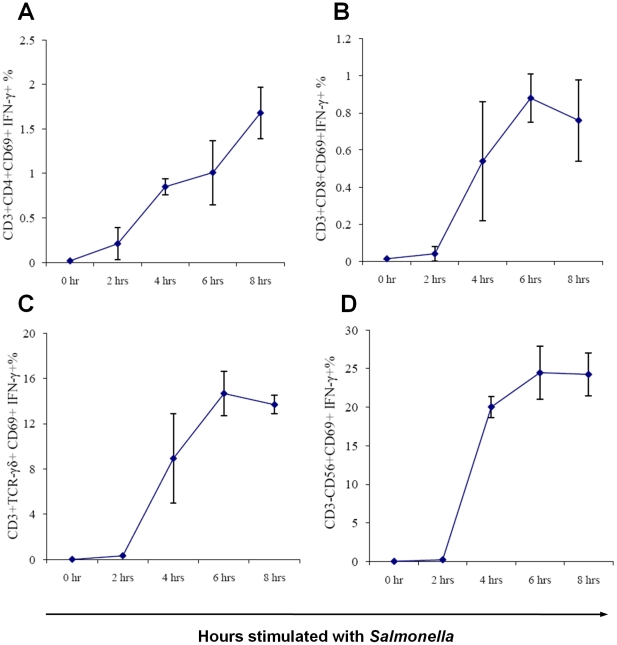
Kinetics of IFNγ production by peripheral blood lymphocytes in response to stimulation with Salmonella.Percentage of IFNγ-producing CD69+ (A) CD4+-T cells, (B) CD8+-T cells, (C) γδ-T cells and (D) NK cells over an eight hour time course following stimulation with S. Typhimurium D23580 homogenate added at 0 hours with addition of Brefeldin A at 2 hours. Data are mean ± sd of three experiments.